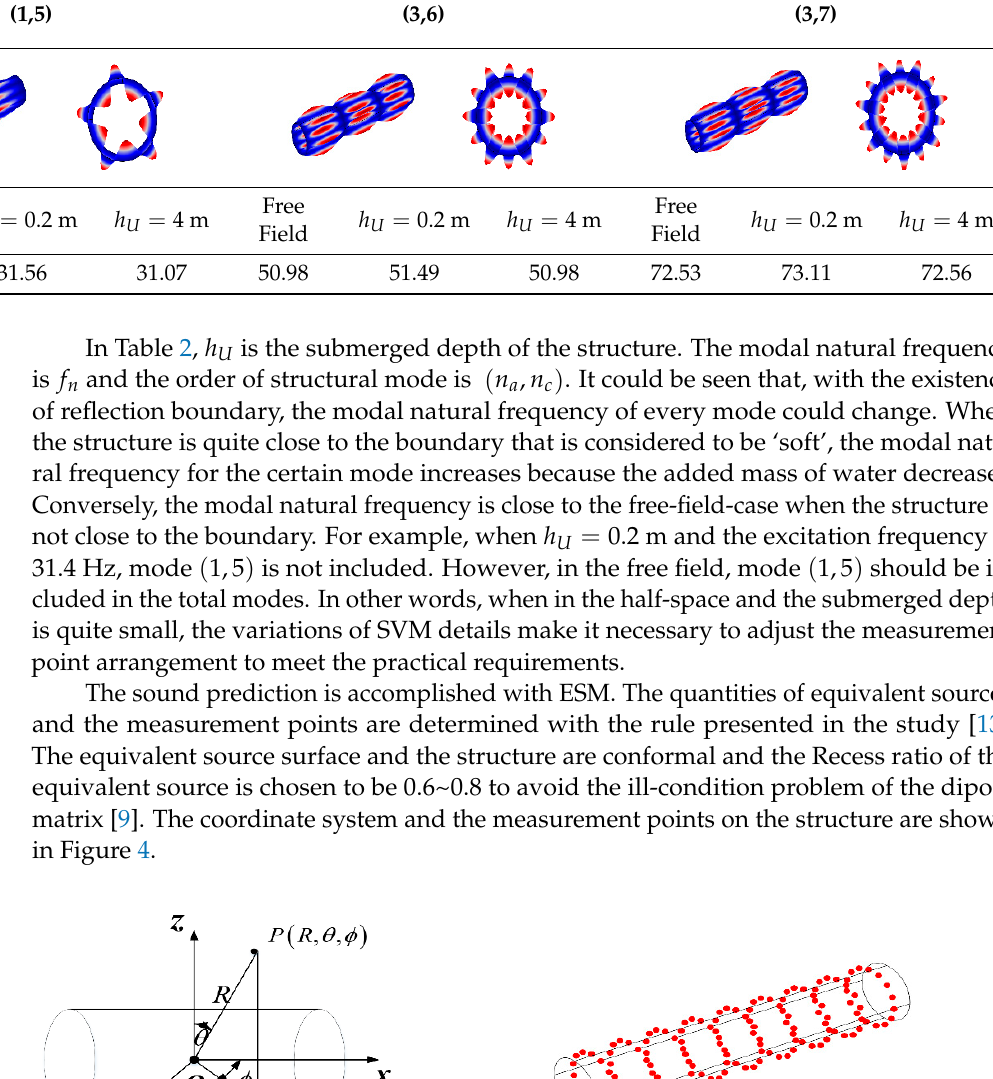
Table 2 . Some low-order modes and modal natural frequencies in different acoustical environments. Mode